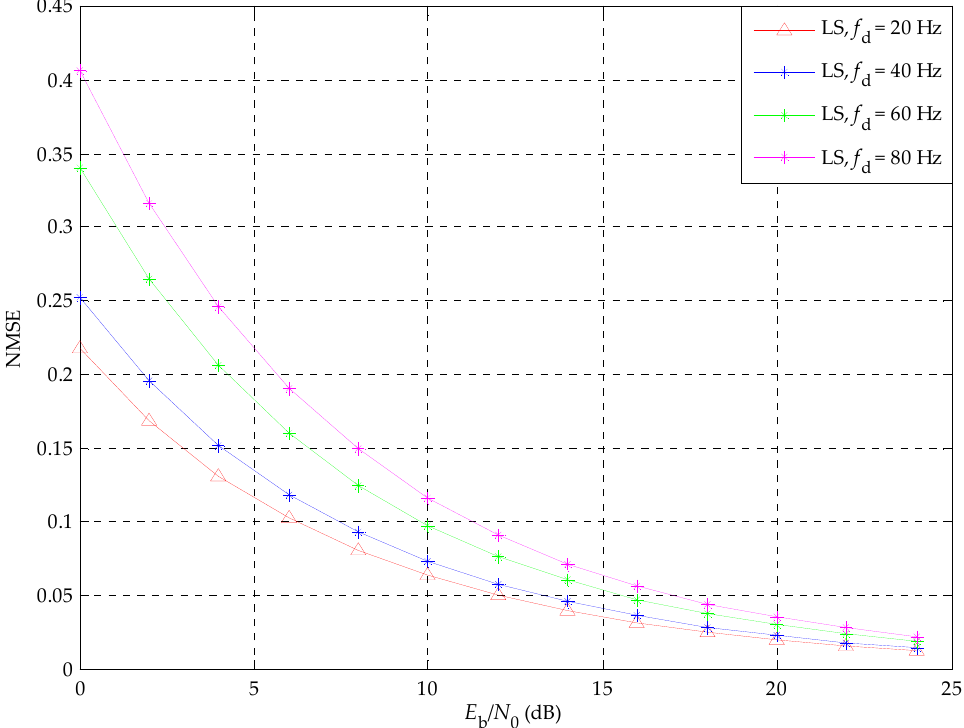
Figure 11. NMSE performance of the OFDM/16-QAM system over Rayleigh fading channels with Doppler spread of 20, 40, 60, and 80 Hz.